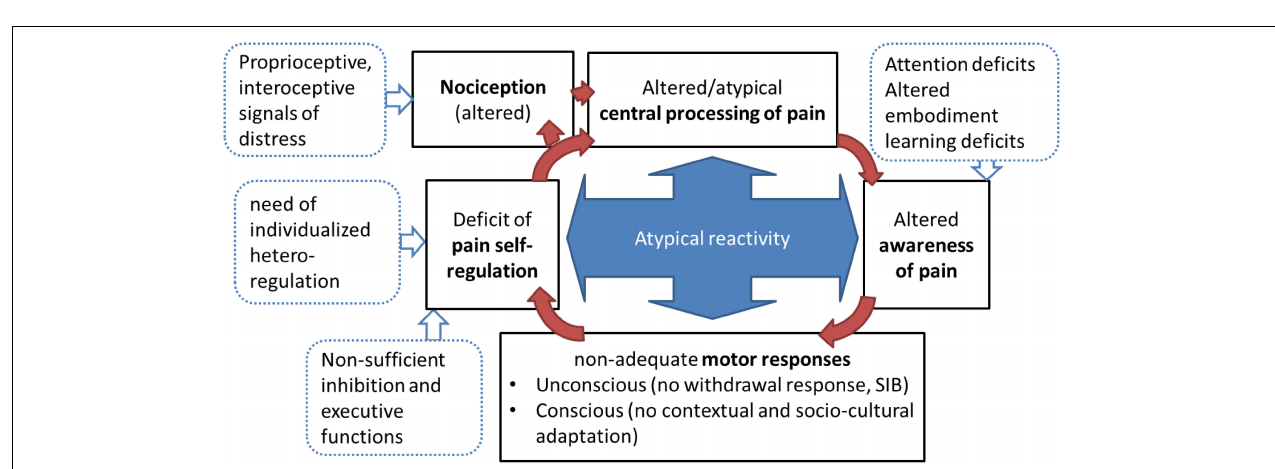
FIGURE 3 | The pain cycle in ASD with possible impacts from suggested mechanisms, modified integrated model, adapted from Dubois et al. (23), Rattaz et al. (24), and